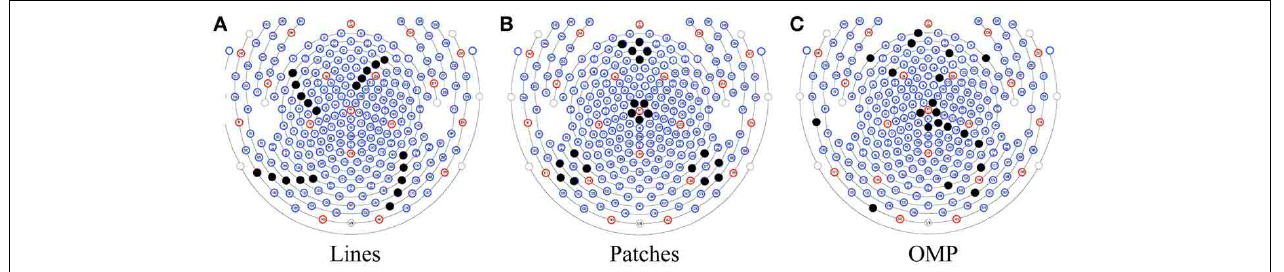
FIGURE 3 | Three patterns for insulating channels (solid black dots): (A) the Lines pattern, (B) the Patches pattern, and (C) a pattern selected by OMP.